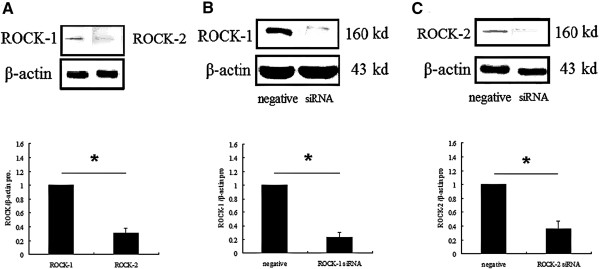
ROCK-1 and ROCK-2 protein expression in Y79 cell lines. (A) ROCK-1 and ROCK-2 protein expression in Y79 cell (*P < 0.05, n = 3). (B) Western blotting shows the marked decrease in the band intensity of the Y79 cells treated with ROCK-1 siRNA for 48 hours compared to negative control siRNA treatment (*P < 0.05, n = 3). (C) Western blotting shows the marked decrease in the band intensity of the Y79 cells treated with ROCK-2 siRNA for 48 hours compared to negative control siRNA treatment (*P < 0.05, n = 3).